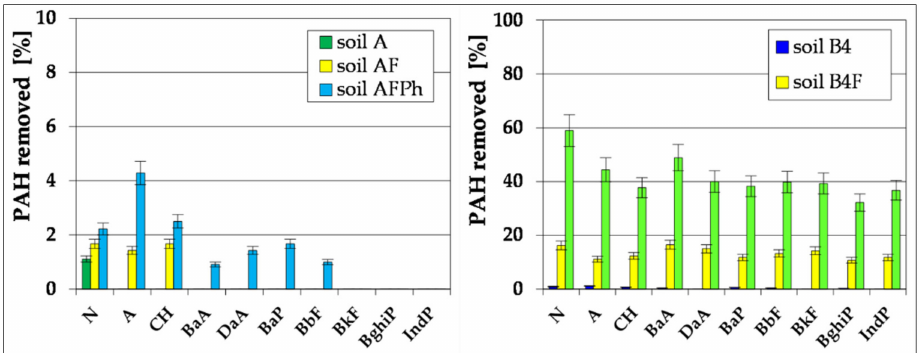
Figure 6. Comparison of the reduction in the content of individual PAH during phytoremediation of soils: raw (A, B4), after fertilization (AF, B4F) and after phytoremediation carried out with M. officinalis (AFPh, B4FPh) (repetition number n = 5–6, p < 0.05). Naphthalene (N), Anthracene (A), Chryzene (CH), Benzo(a)anthracene (BaA), Dibenzo(a,h)anthracene (DaA), Benzo(a)pyrene (BaP), Benzo(b)fluoranthene (BbF), Benzo(k)fluoranthene (BkF), Benzo(ghi)perylene (BghiP), Indeno(1,2,3- cd)pyrene